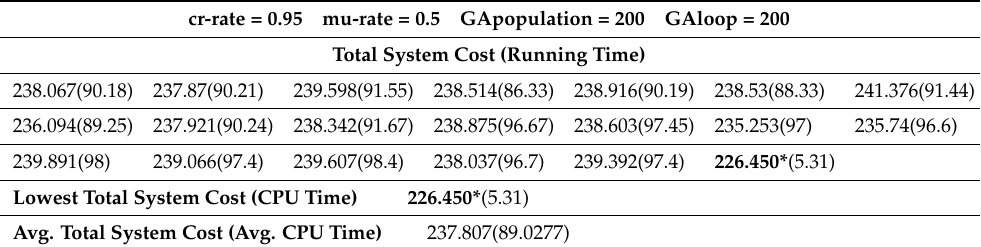
Table 13. The total system costs of 20 simulation runs obtained by MAHA–MGA for the n -stage standby system.